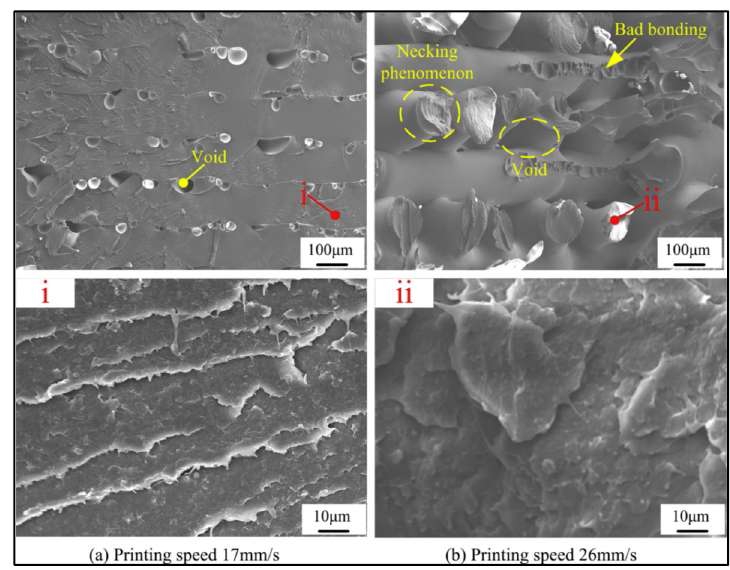
Figure 15. SEM micrographs of tensile-fracture surfaces of PEEK samples printed under different speeds ( a ) at 17 mm/s and ( b ) at 26 mm/s [84].